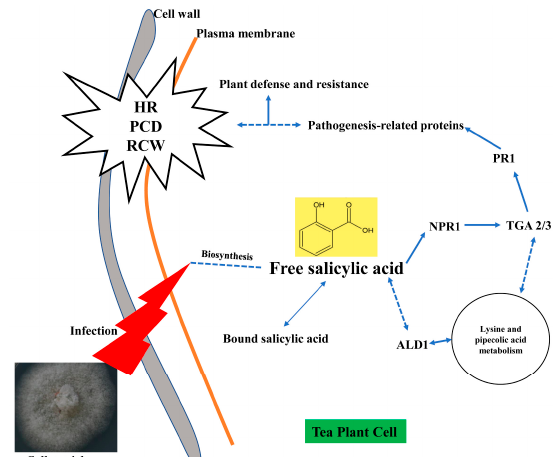
Figure 8. A hypothetical model for SA accumulation and related gene expression in tea plant immunity. Solid lines indicate actual regulations of signaling effect. Dotted lines indicate hypothetical regulations of signaling effect.